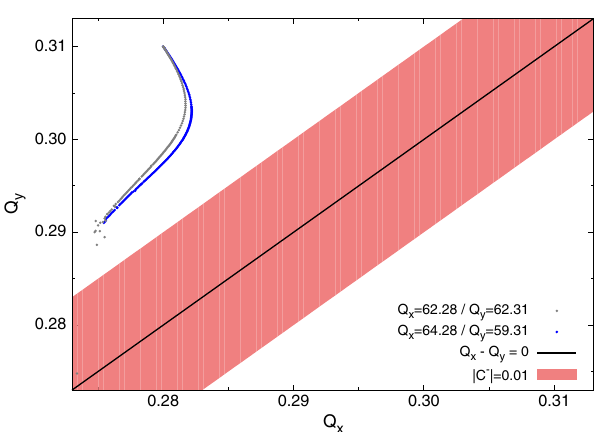
FIG. 5. Tunes from tracking with linear closest tune approach of 0.015 and nominal octupoles. The kicks in the horizontal plane ranged from 0.5 mm to 4.5 mm while the kicks in the vertical plane were kept at 0.5 mm. The light red area indicates the linear stopband of 0.015 for all cases. The two black lines show the resonances Q x ¼ Q y and Q y ¼ 1 = 3 respectively.